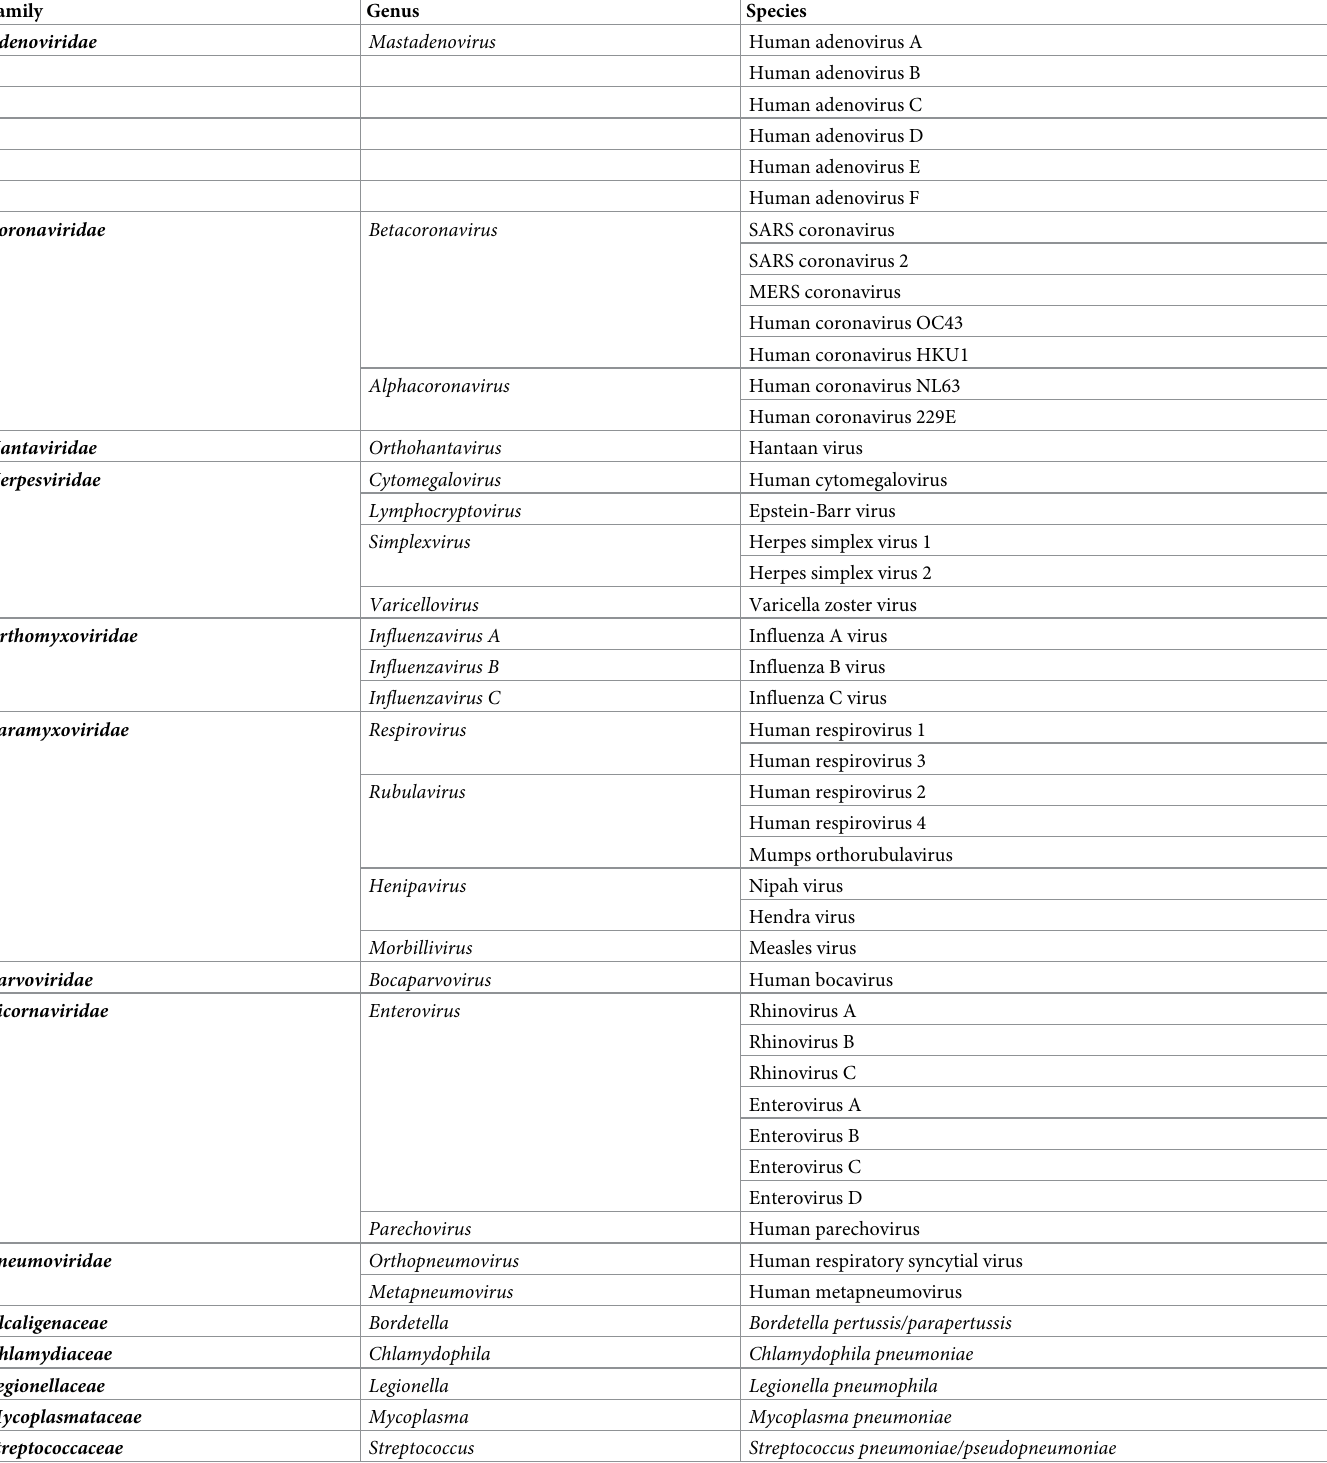
Table 1. List of viruses and bacteria targeted by the RespiCoV